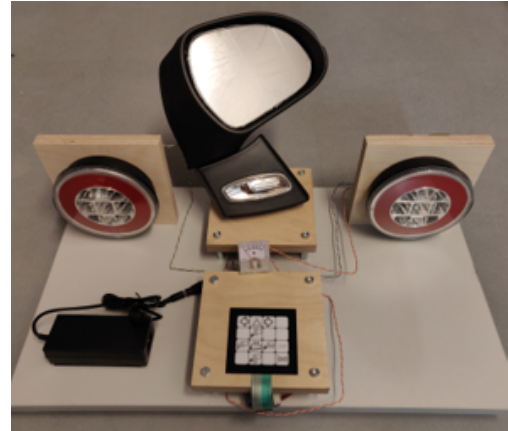
Figure 1. Proof of concept of DLN solution.